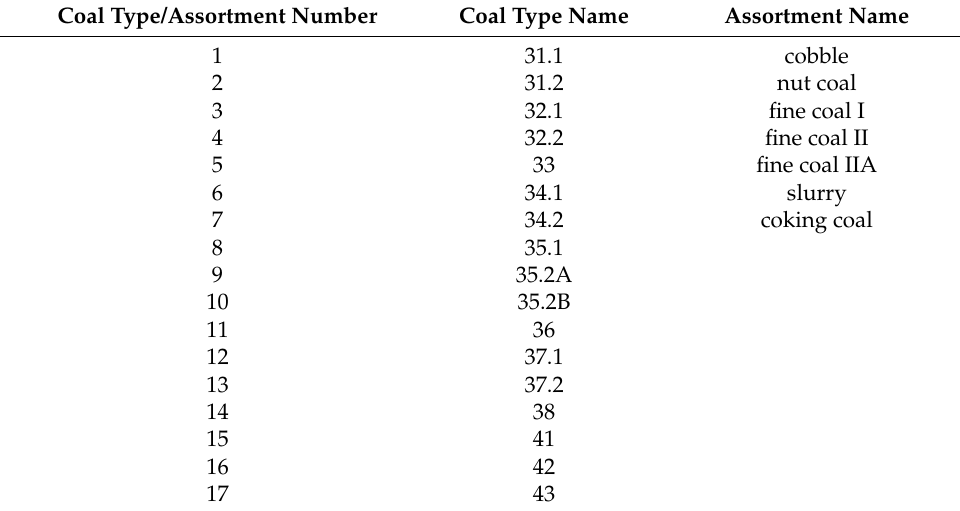
Table 5. List of numbers and names of coal